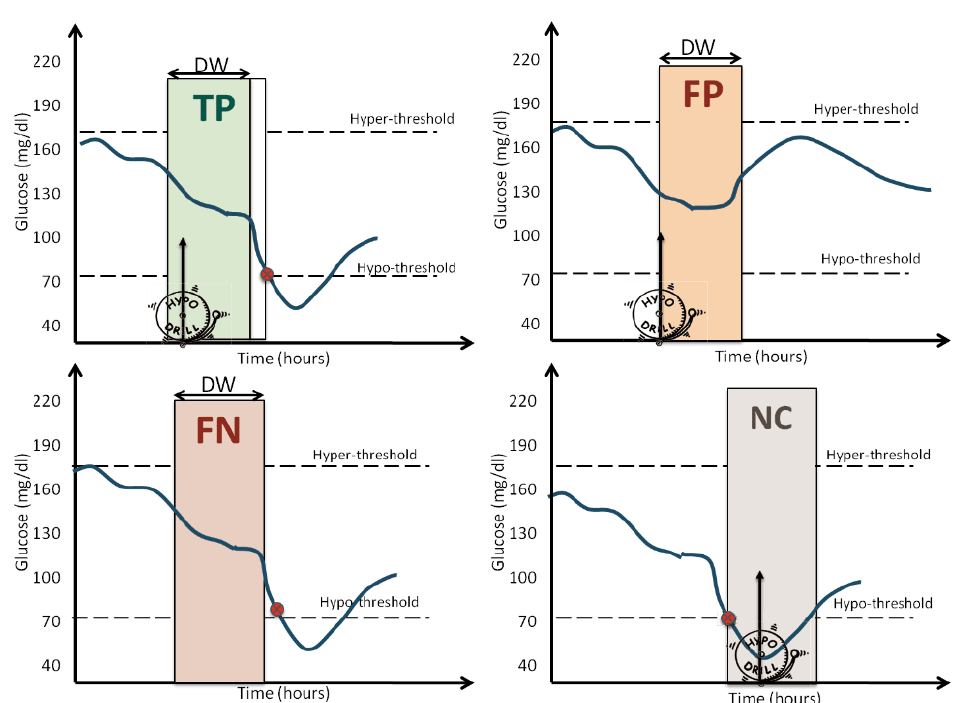
Figure 3. Examples of true positive ( top-left corner), false positive ( top-right corner), false negative ( bottom-left corner), and not countable ( bottom-right